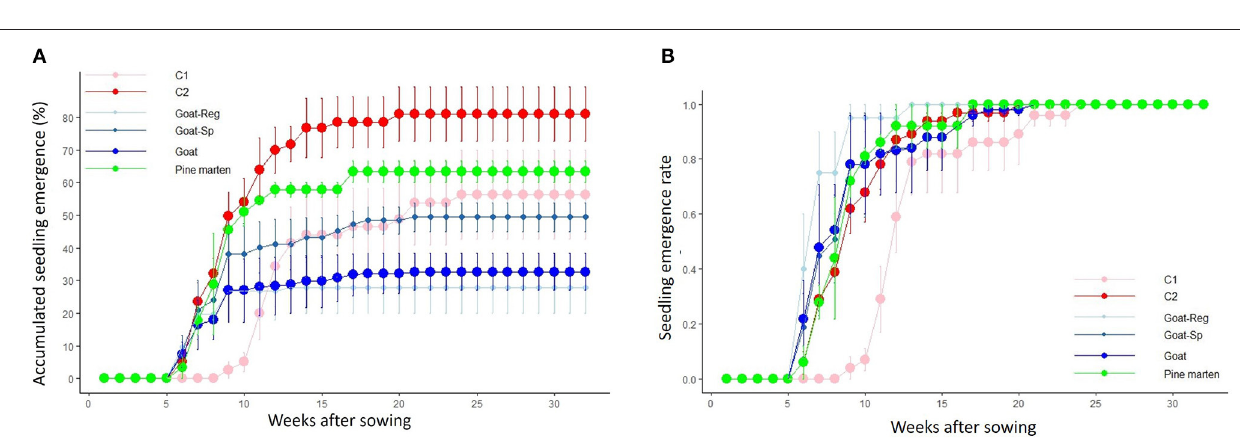
relative qualitative effectiveness of seed dispersers in scenarios again but without considering scolitine-predated seeds. Results